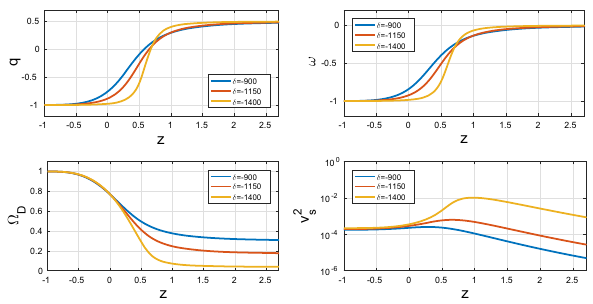
Fig. 2 q , (cid:7) D ( z ) , w and v 2 s ( z ) versus z for some values of δ . Here, (cid:7)